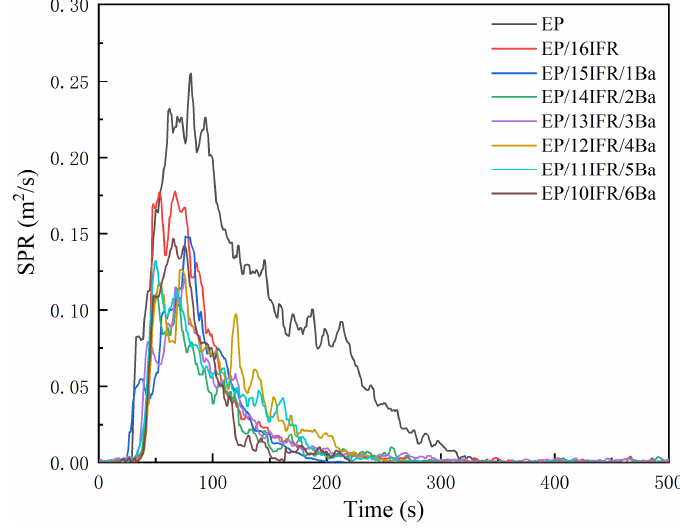
Figure 6. Curves of SPR of pure EP and EP composites with time.